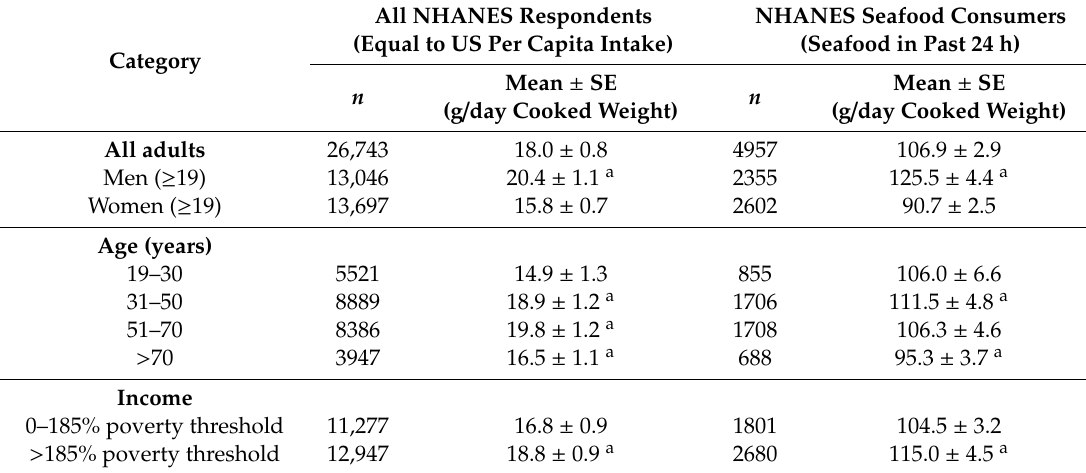
Table 1. Per capita seafood intake in United States adults ( ≥ 19) in the past 24 h (National Health and Nutrition Examination Survey (NHANES) 2007 to